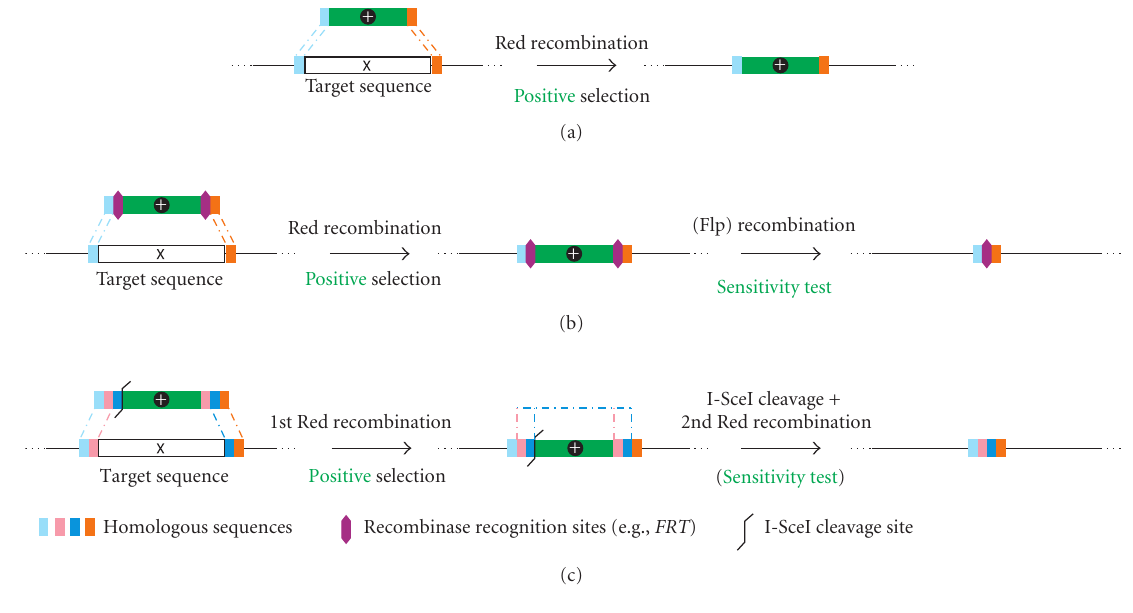
Figure 2: Overview of strategies for the Red-mediated deletion of sequences. Boxes of same color represent identical